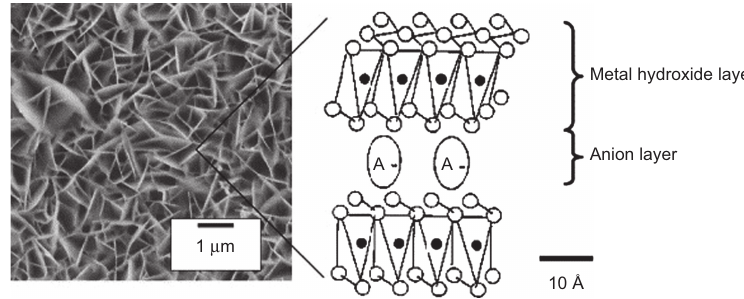
Figure 6 A schematic illustration of the structure of layered double hydroxide nanostructure. Metal hydroxide layers are located on the top and bottom layers, whereas anion layer is located in the middle [126]. (Reprinted from Prog. Organ. Coat. Wong F, Buchheit R. Ultilizing the structural memory effect of layered double hydroxides for sensing water uptake in organic coatings. 51, 91–102. Copyright 2004, with permission from Elsevier.)